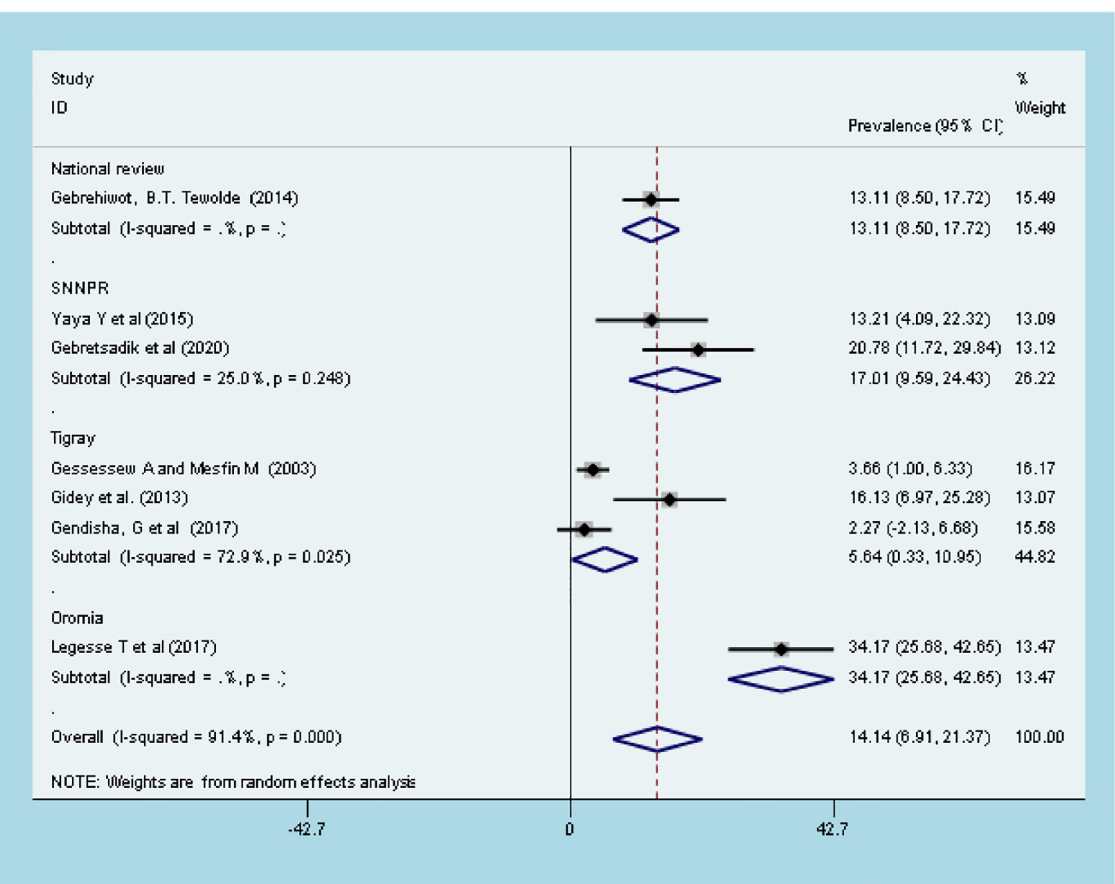
Fig 2. Forest plot of overall incidence of maternal death among obstructed labor women in Ethiopia.